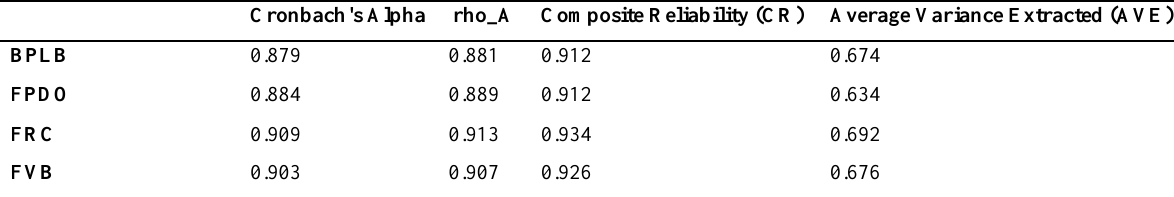
Table 2: Construct Reliability and Validity